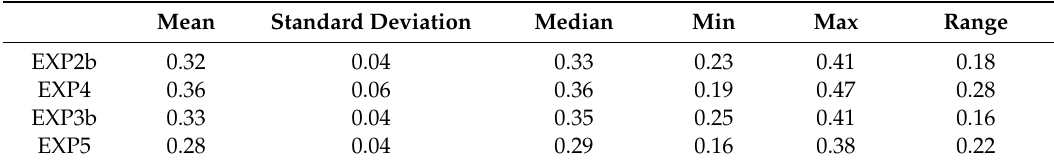
Table 25. VWC (m 3 m − 3 ) (0–10 cm) simulated by UTOPIA and NOAH, initialized with GLDAS, at the CO station.